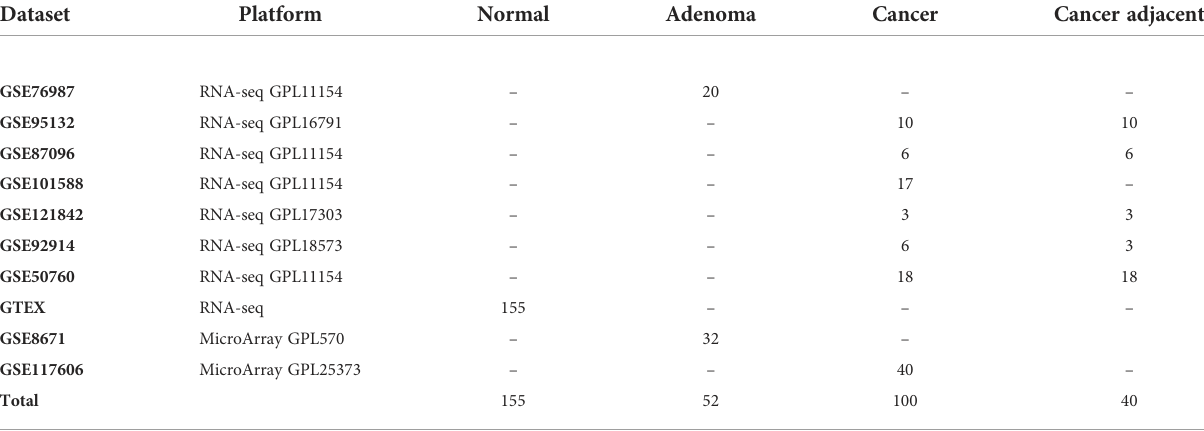
TABLE 1 The training datasets used in this